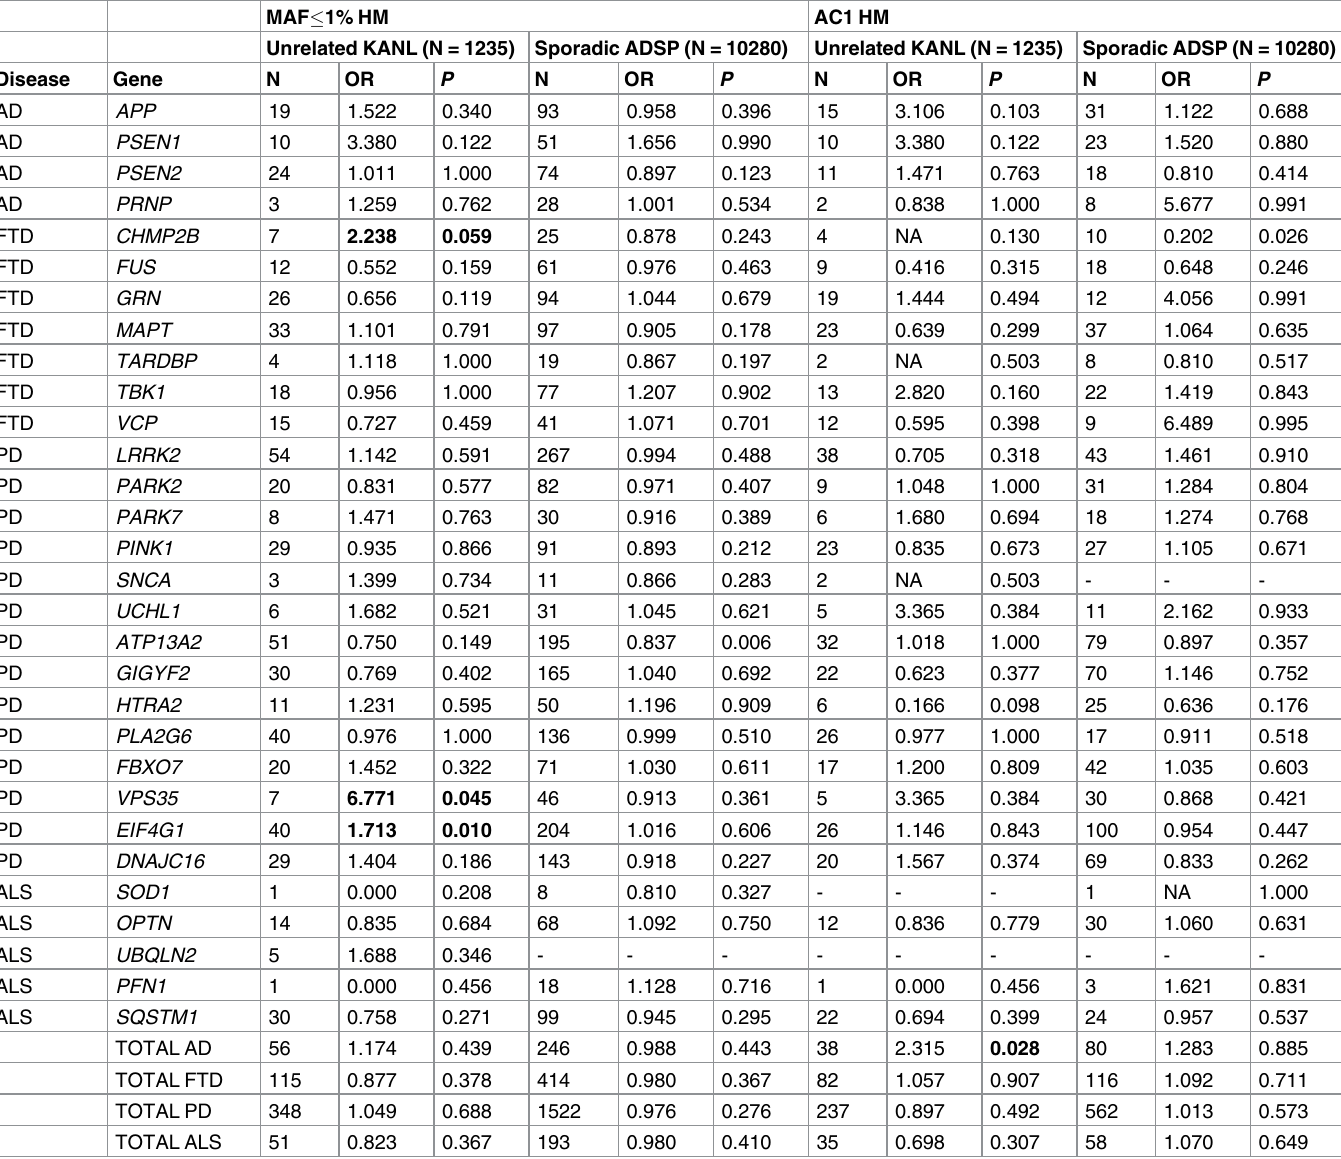
Table 3. Burden test for KANL and ADSP unrelated datasets. Collapsingand combine(CMC) test of rare variants by Fisher’s exact test for (i) variants with a MAF (cid:20) 1% and categorized to have a high or moderatedeffect (MAF (cid:20) 1% HM) and (ii) singletonvariants categorized to have a highor moderated effect (AC1 HM), for the unrelateddatasets analyzedin this study (unrelatedKANL and SporadicADSP). Number of polymorphic variants (N), odds ratio (OR) and two sided pvalue( P ) are given. Enrichedgenes with nominallysignificantpvalues are bold